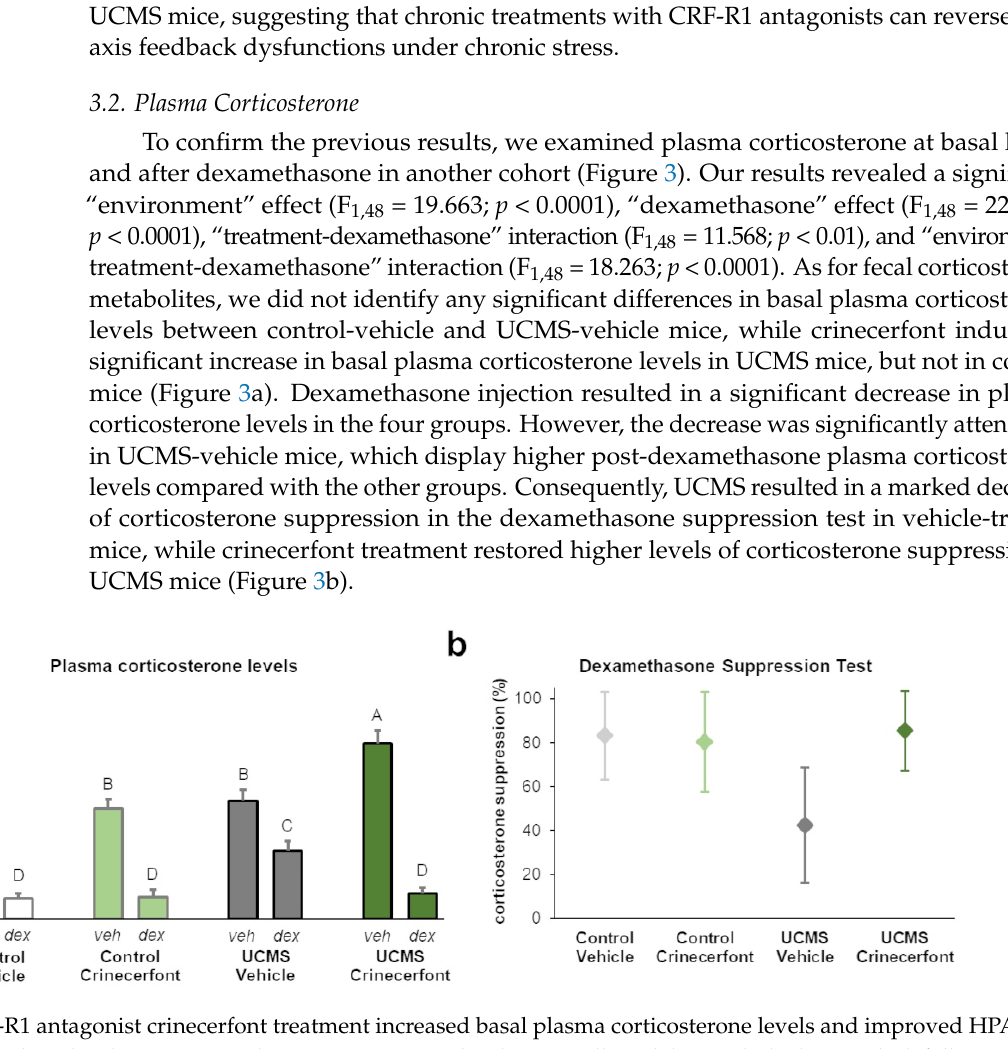
vs. UCMS ‐ vehicle mice. Data represent mean ± sem. ( b ) The dexamethasone suppression test allowed assessing the integ ‐ rity of the HPA axis negative feedback. UCMS significantly decreased the ability of corticosterone suppression in vehicle mice, an effect that tended to be cancelled with crinecerfont treatment. n = 8–11 per group; ¤ p < 0.10 and ** p < 0.01 between line ‐ connected groups. Scatterplot represents individual results, with the ‘+’ symbol showing the mean and the bar repre ‐ senting the median.